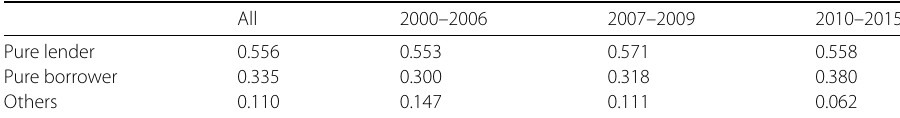
Table 1 Fraction of each bank type in the data. “Pure lender” (“pure borrower”) denotes the banks that lend to (borrow from) but never borrow from (lend to) other banks